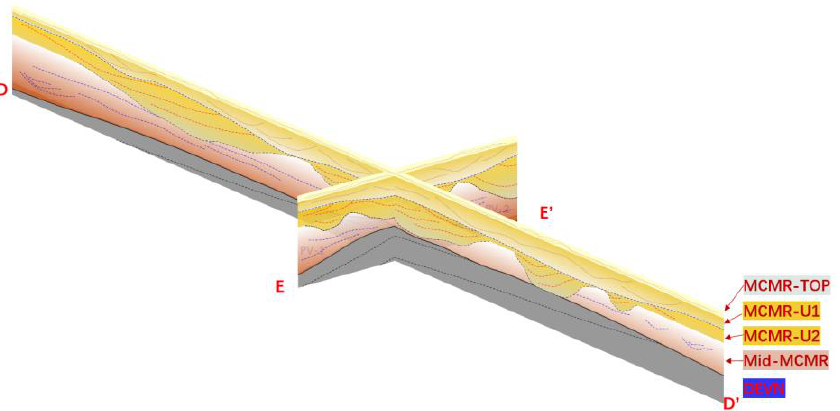
Figure 10. Incision and fill pattern of the McMurray Formation. (The section location is shown in Figure 1).